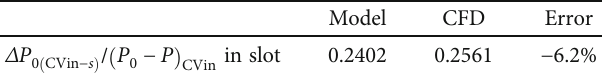
Table 4: Comparison of results of theoretical model and CFD for average SPL coe ffi cient in